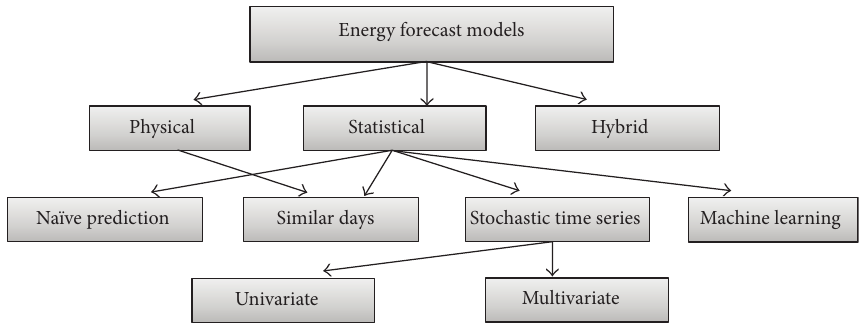
Figure 3: Classification of energy forecasting models, adopted from